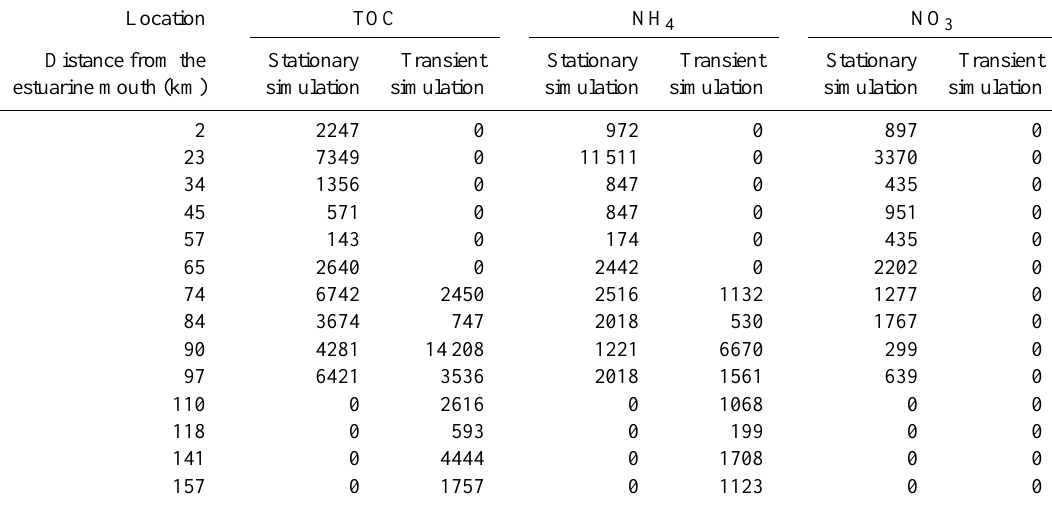
Table 6. Lateral loads (mmols − 1 ). For more information, refer to Vanderborght et al. (2007) and Arndt et al. (2009).